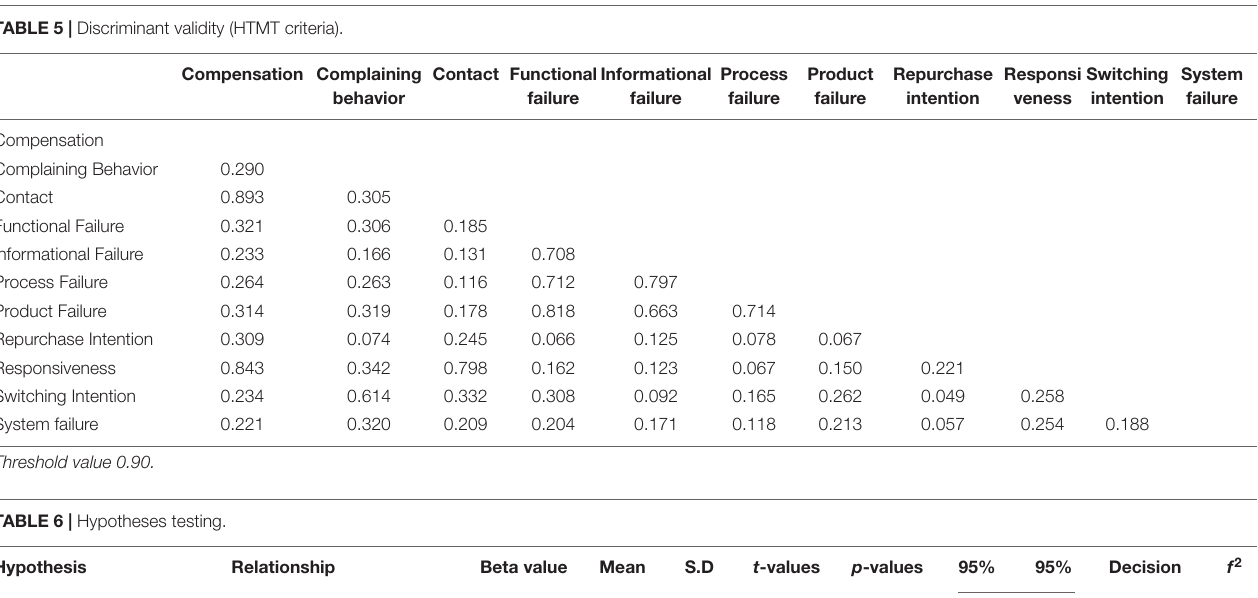
TABLE 5 | Discriminant validity (HTMT criteria).